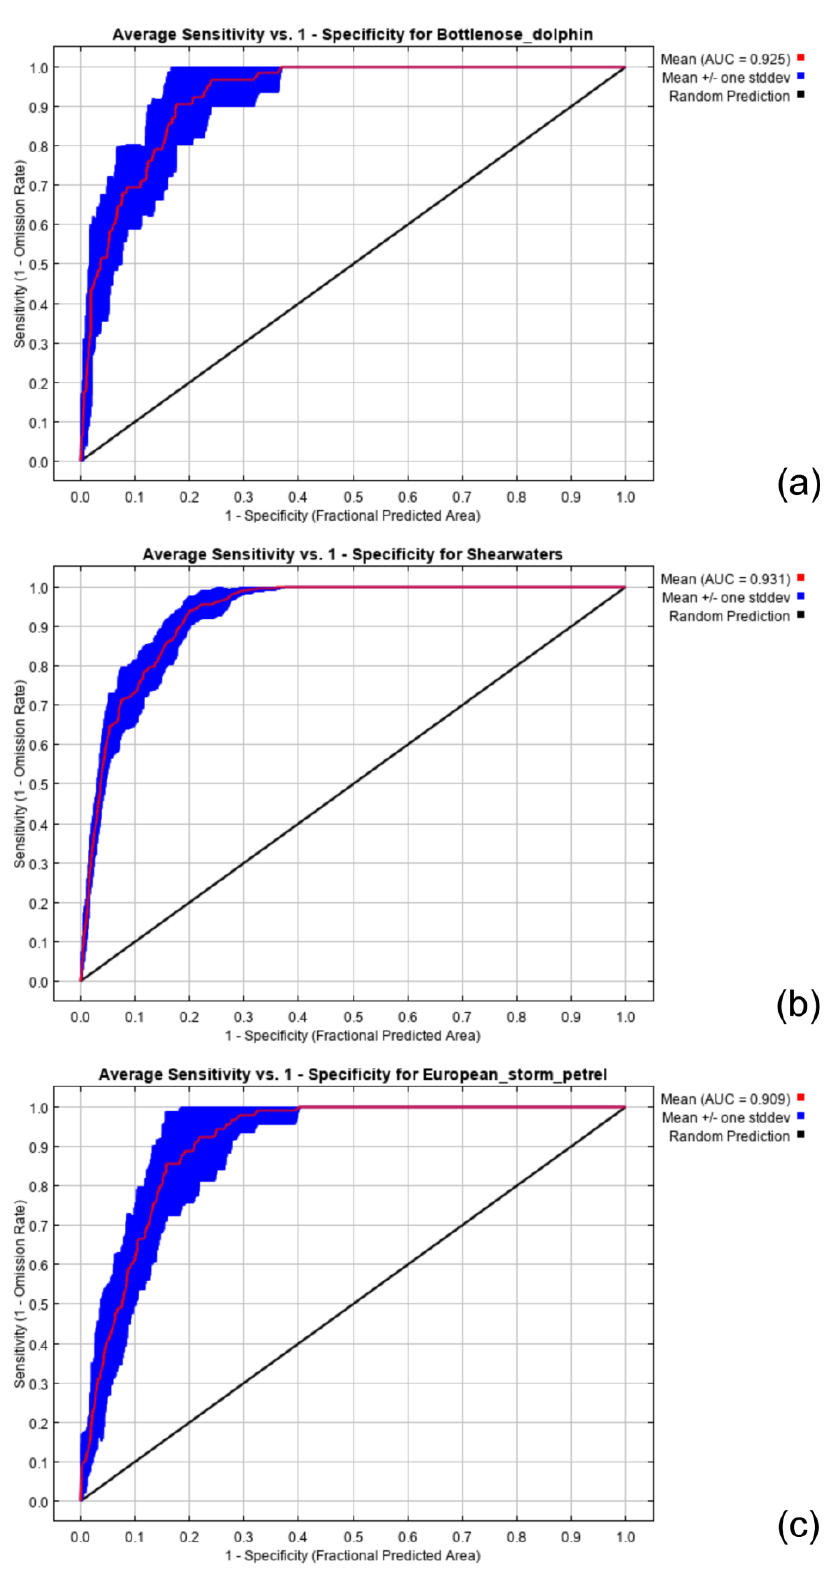
Figure 8. MaxEnt AUC for ( a ) bottlenose dolphins, ( b ) shearwaters, and ( c ) European storm petrels. The graphs show average sensitivity (mean AUC, red) against random precision (black) to evaluate the precision of the model.